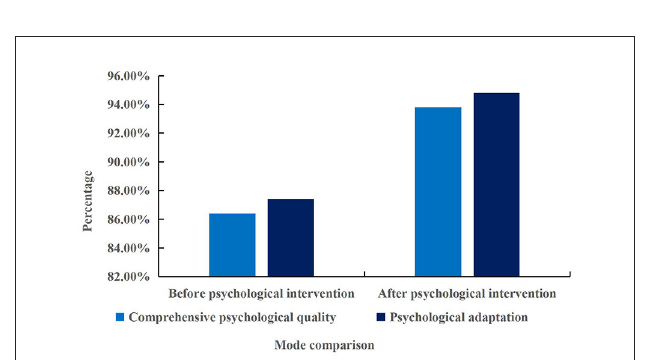
FIGURE7 Comprehensive psychological quality and psychological adjustment ability of civil servants after psychological